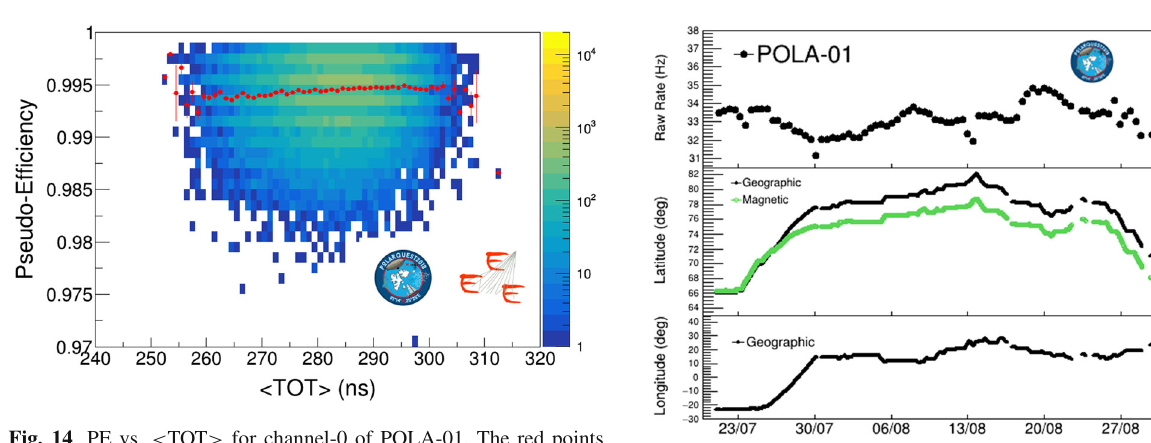
Fig. 14 PE vs. < TOT > for channel-0 of POLA-01. The red points represent the average PE values